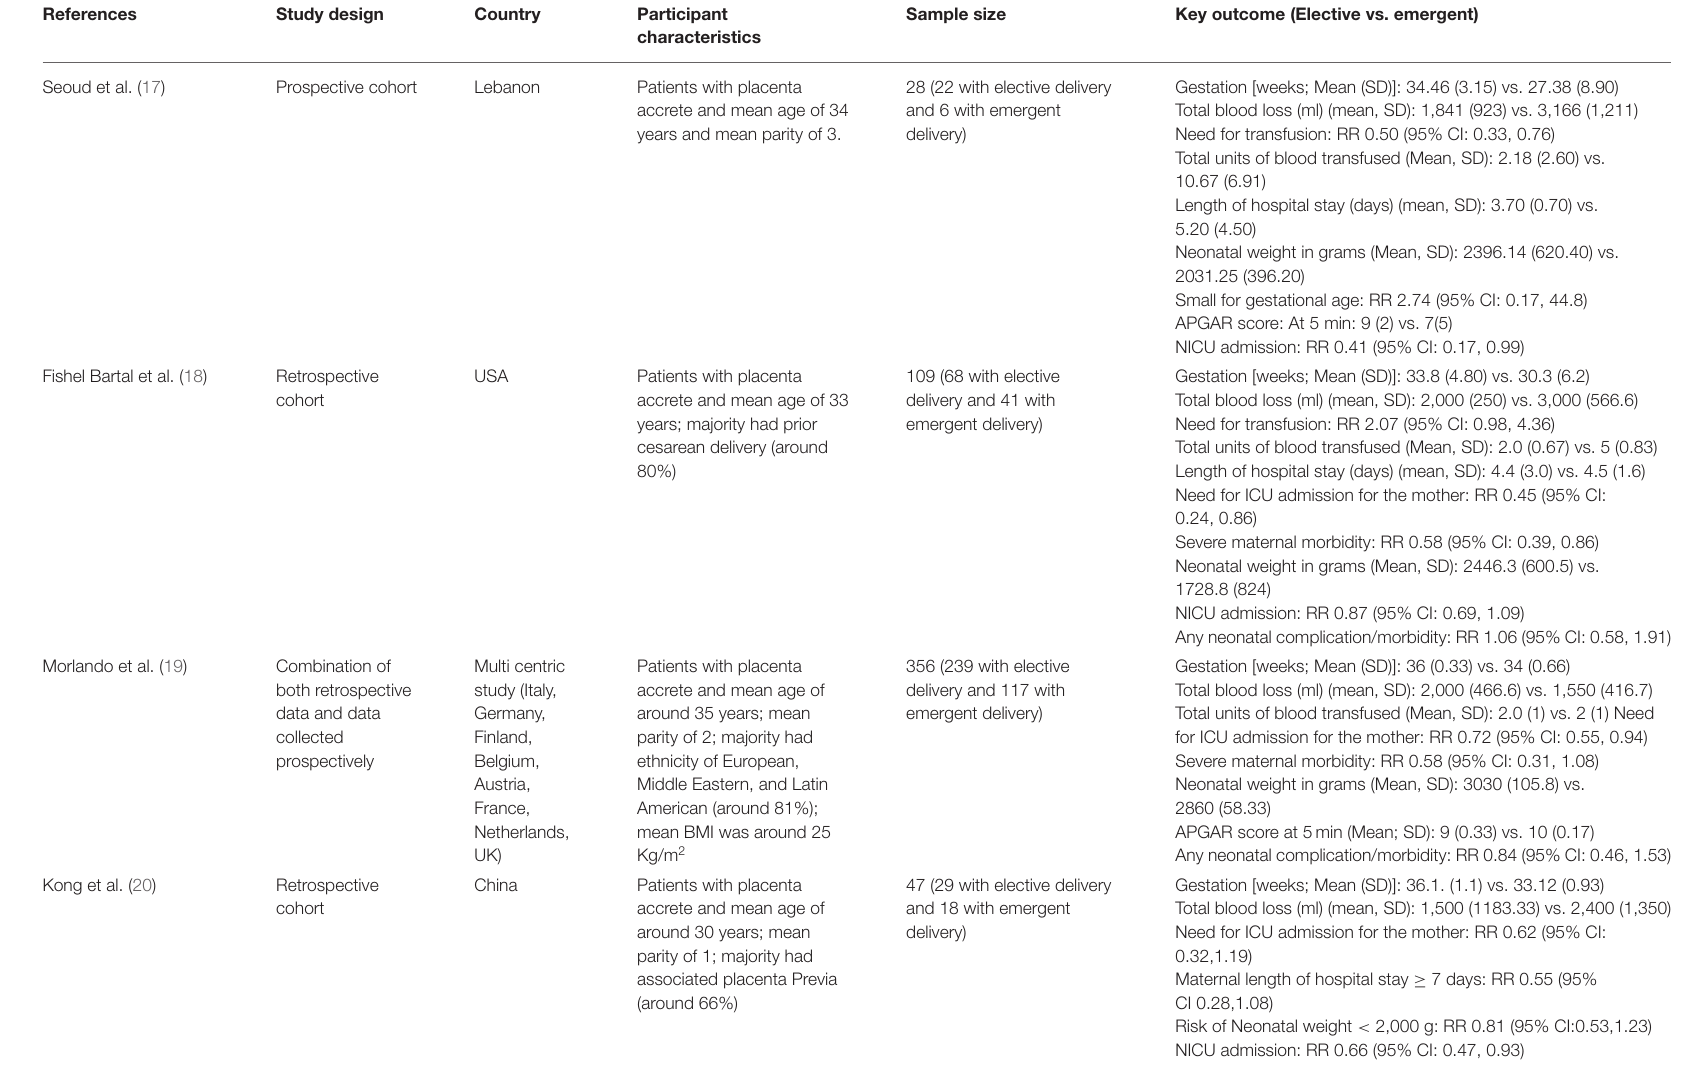
TABLE 1 | Summary of included studies.